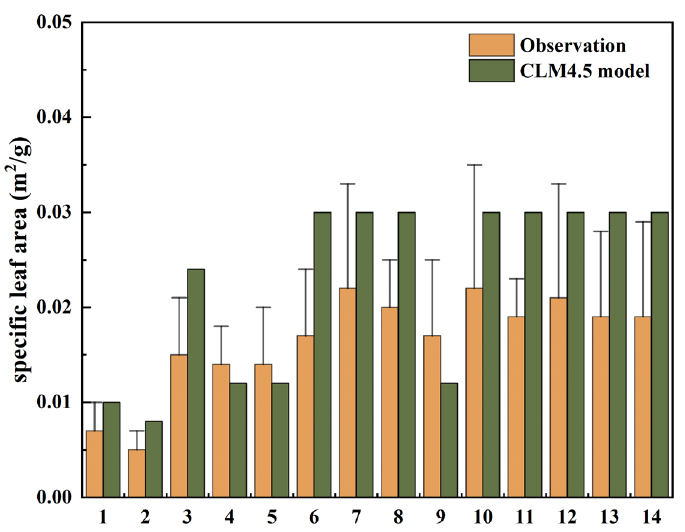
Figure 2. The differences in specific leaf area (SLA) between observation data in China and default values in the CLM4.5 model. The error bar shows the standard deviation. 1, temperate NET; 2, boreal NET; 3, boreal NDT; 4, tropical BET; 5, temperate BET; 6, tropical BDT; 7, temperate BDT; 8, boreal BDT; 9, temperate BES; 10, temperate BDS; 11, boreal BDS; 12, C3 grass; 13, C4 grass; 14, rainfed crop.